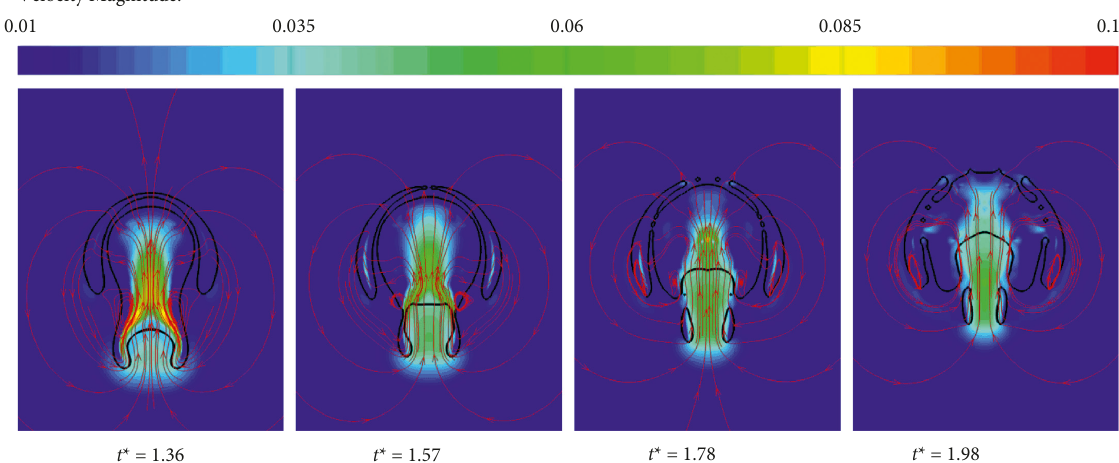
Figure 6: Coalescence process between two bubbles and corresponding flow field at Bo � 50, Ar � 300, ρ